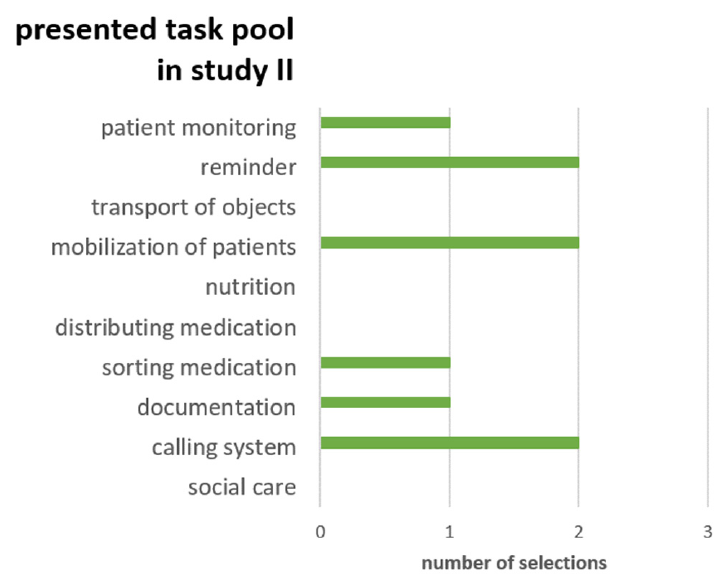
Figure 7. Task pool presented in study II including number of selections.